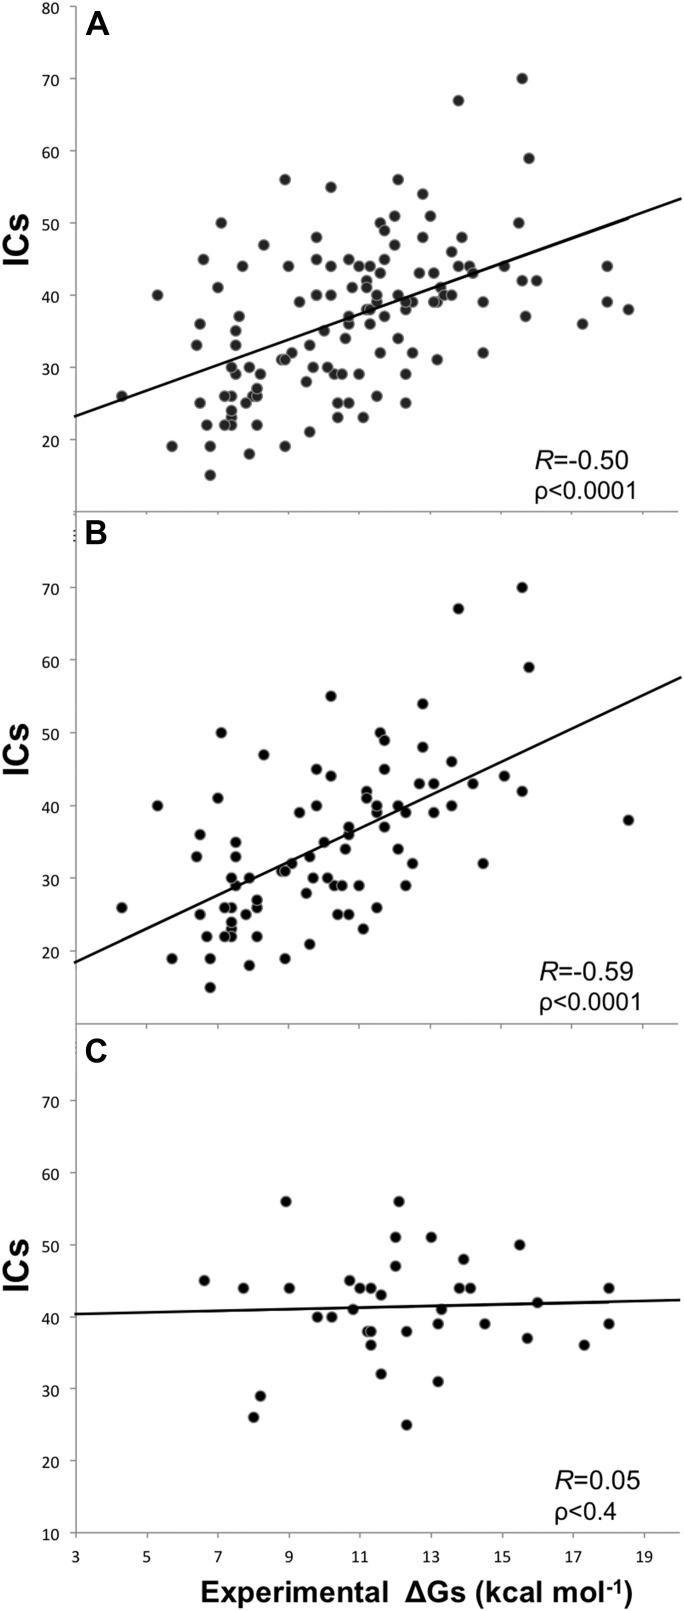
Plots of inter-residue contacts (ICs) vs experimentally determined binding affinities (ΔGs) of protein–protein complexes.(A) Full dataset (122 complexes), (B) reliable experimental methods only (stopped-flow, surface plasmon resonance, spectroscopy, isothermal titration calorimetry) (81 complexes), and (C) non-reliable experimental methods (inhibition assay and fluorescence) (36 complexes). The trend line and corresponding Pearson correlation coefficients and p-values (ρ) are reported in each plot; binding affinities are reported as absolute values.